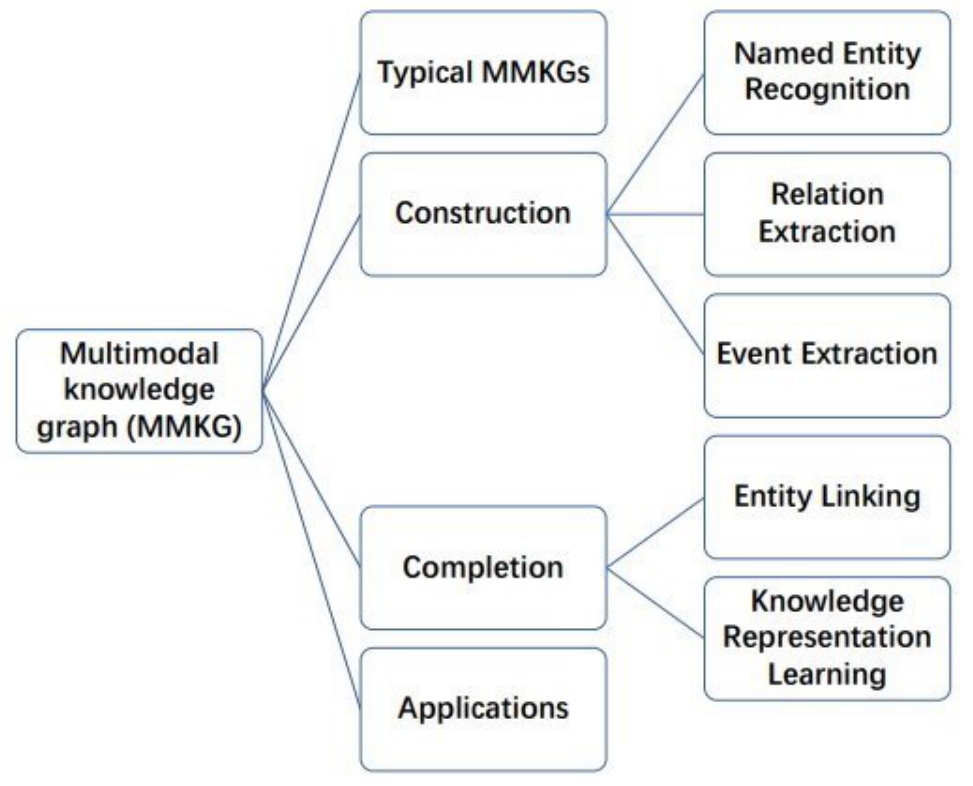
Figure 2. The taxonomy of the survey on